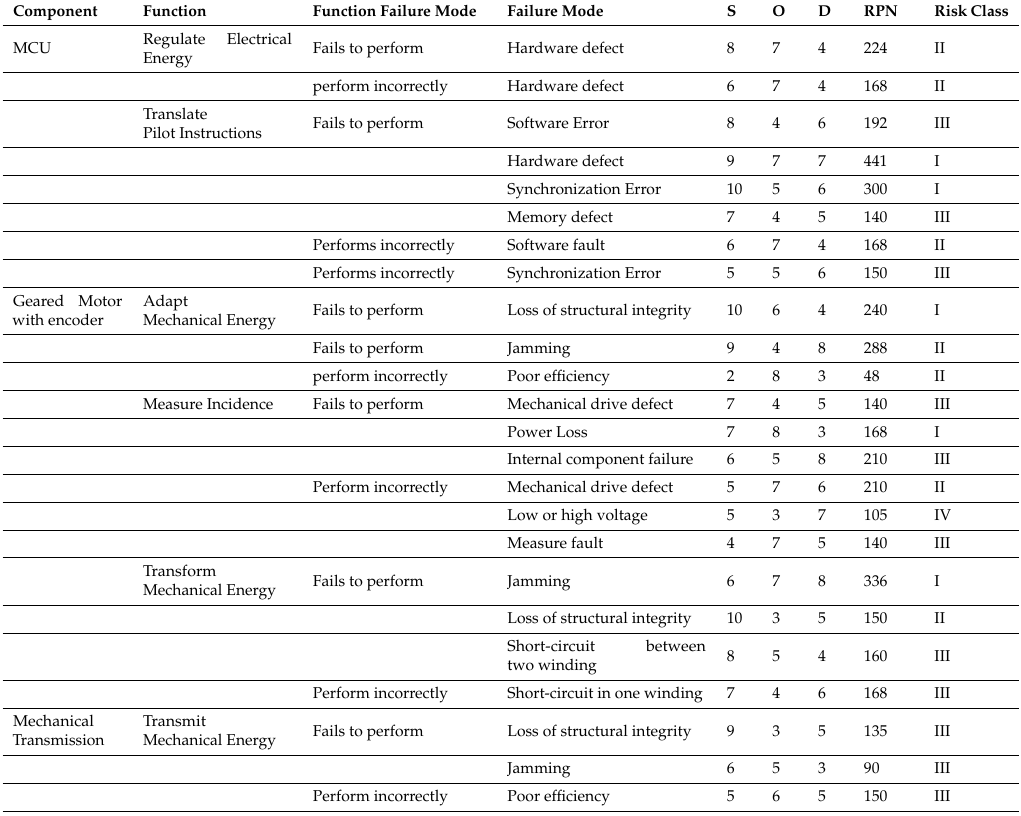
Table 2. Initial Failure Mode and Effects Analysis (FMEA) for Electro-Mechanical Actuator (EMA). Component